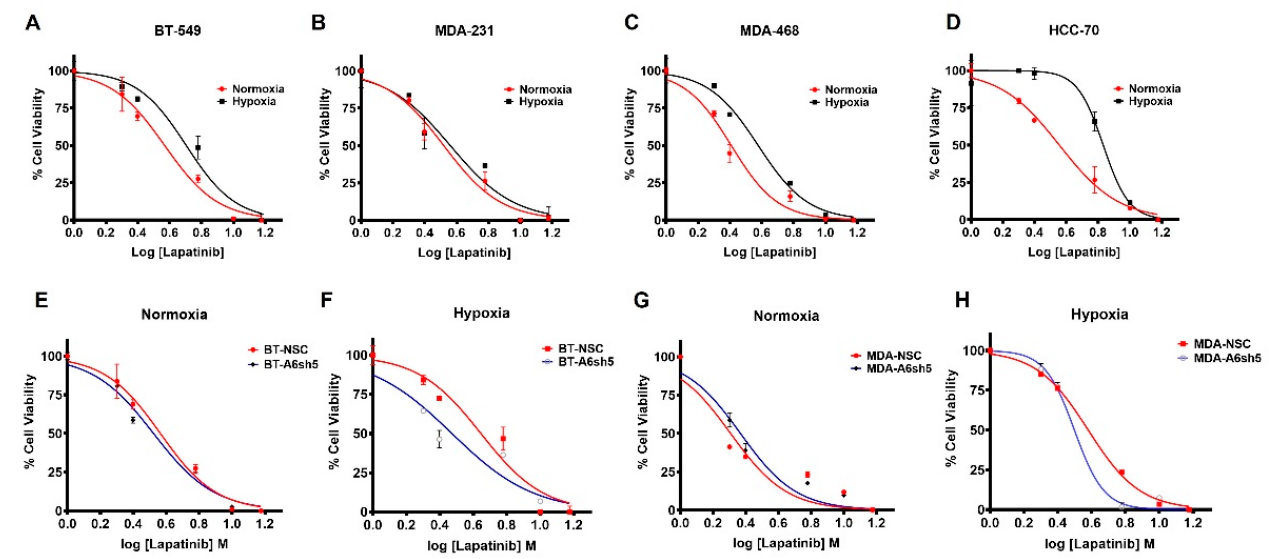
Figure 5. Hypoxia induced AnxA6 expression is associated with lapatinib resistance in TNBC cells Parental TNBC cells ( A,D ) , and control AnxA6 expressing NSC and AnxA6 down regulated (A6sh5) MDA-468 and BT-549 cells ( E,H ), were seeded at a density of 1.0 x 10 4 cells/well in quadruplicate in 96-well plates and incubated overnight. Cells were then treated with serial dilutions of the drug ± hypoxia for a further 72 h and cell proliferation was measured using the Prestoblue cell viability reagent. Cell viability was calculated relative to untreated DMSO controls, and the IC 50 values were calculated by non-linear regression using GraphPad prism, v.9.3. All data are presented as mean ± SEM, n = 4 . Table 1. Effects of AnxA6 downregulation on the response of TNBC cells to lapatinib under hypoxia.